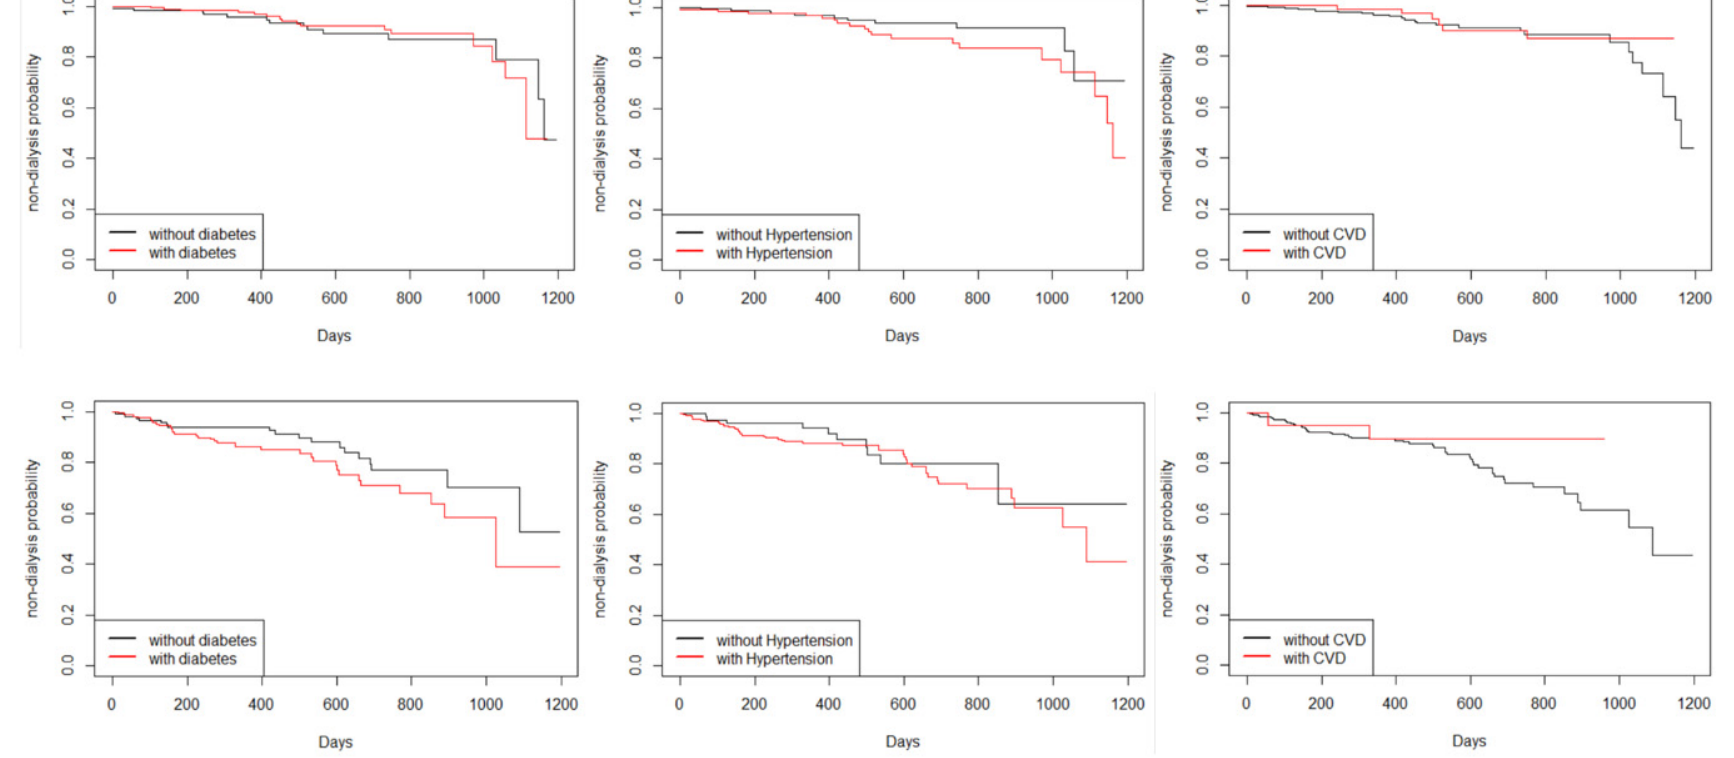
Figure 2. The Kaplan–Meier curves of non-dialysis for CKD patients with or without diabetes, hypertension, and cardiovascular disease in Stage 3a CKD (upper panel) and Stage 3b to Stage 5 CKD (lowest panel).